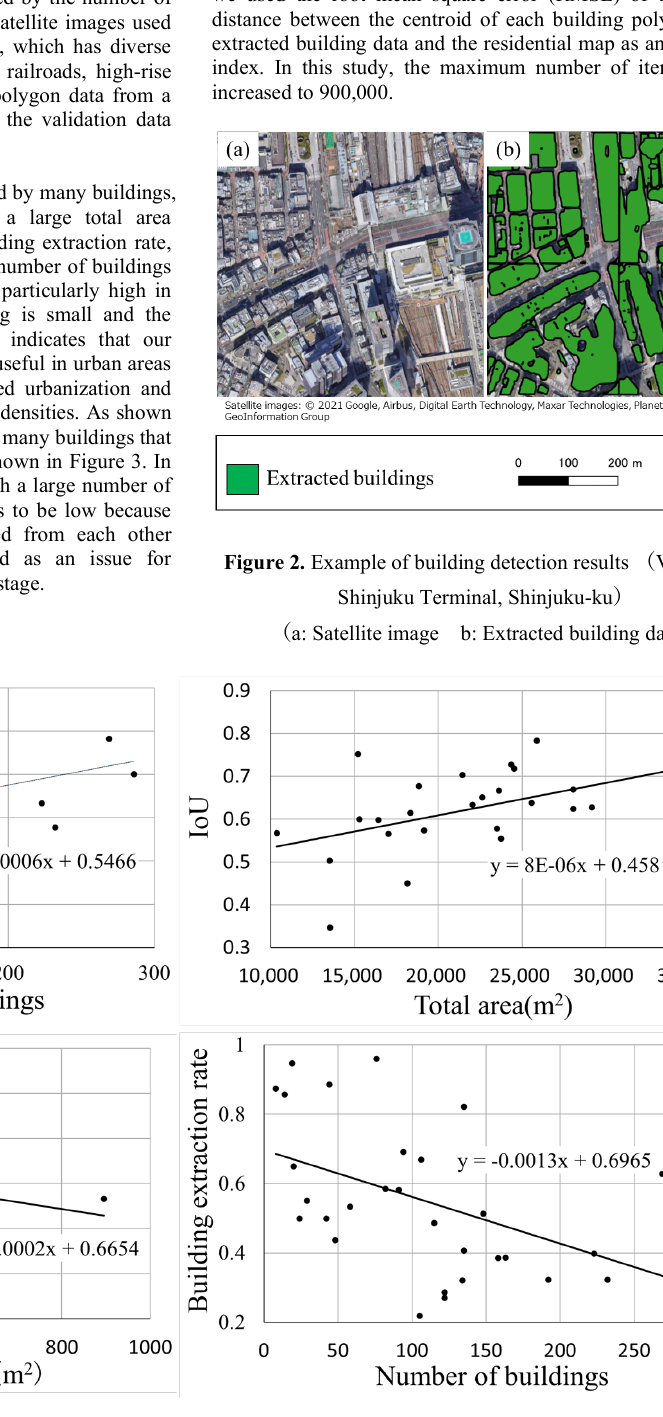
Figure 3 . Relationship between indicator of regional characteristics and extraction